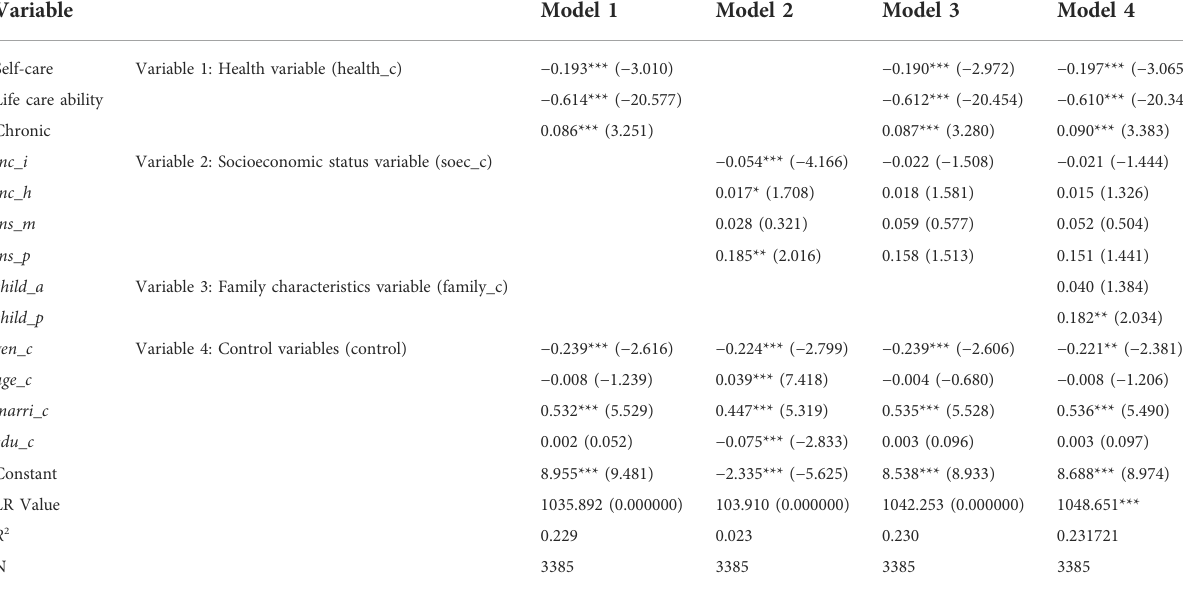
TABLE 2 Regression results for whether the rural elderly can obtain the supply of old-age care services. Explained variable: supply of elderly services ( Y c1 ).